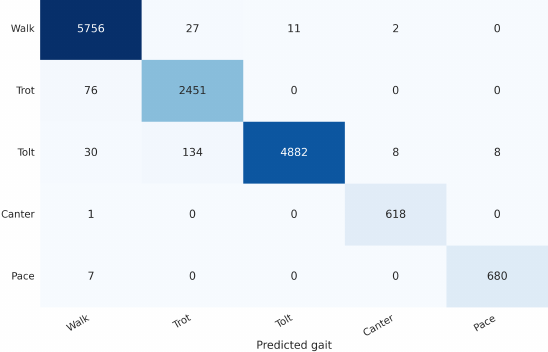
Figure 12. Confusion matrix for the gait classification model on the test set with 98.0% accuracy (best out of 9 random seeds with average accuracy at 96.1% and median accuracy at 95.8%). We use an input interval of length 1.5 s, where the input signal is aligned to the horse’s frame of reference.